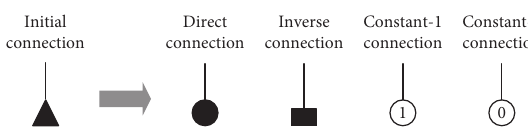
Figure 2: Four connection types in the synaptic layer.